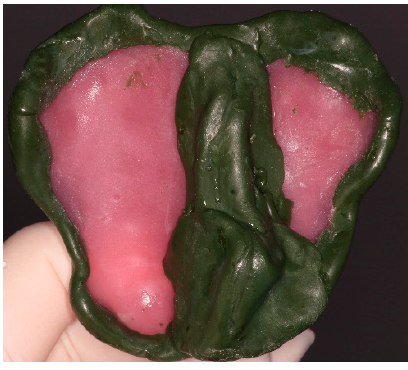
Figure 3. Maxillary master cast.